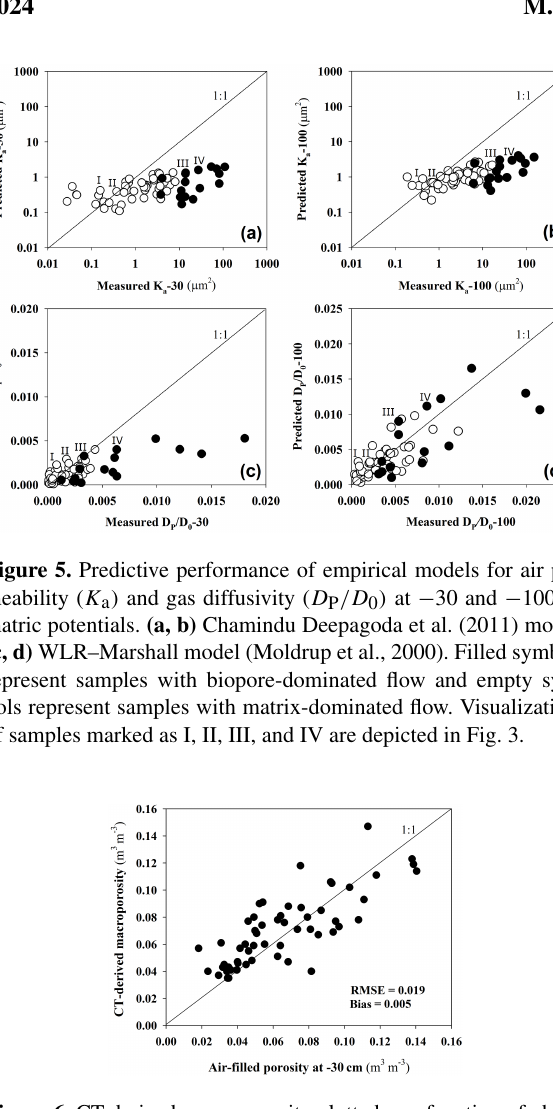
Figure 6. CT-derived macroporosity plotted as a function of physi- cally measured air-filled porosity at − 30cm matric potential.